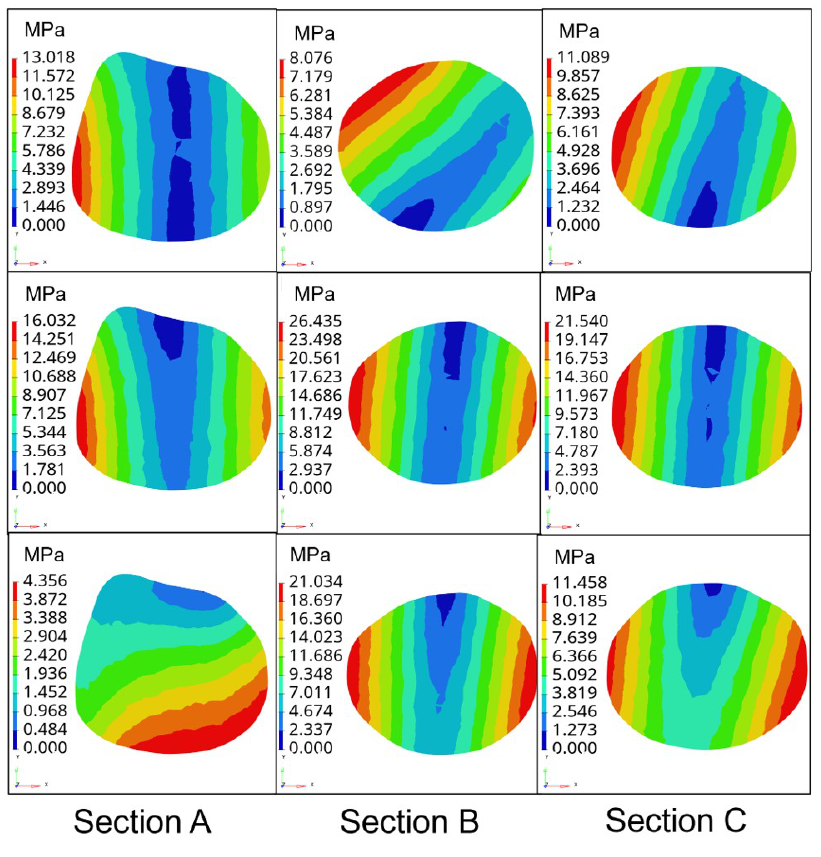
Figure 9. Stress nephogram distribution of three types of femur stem with three conditions.